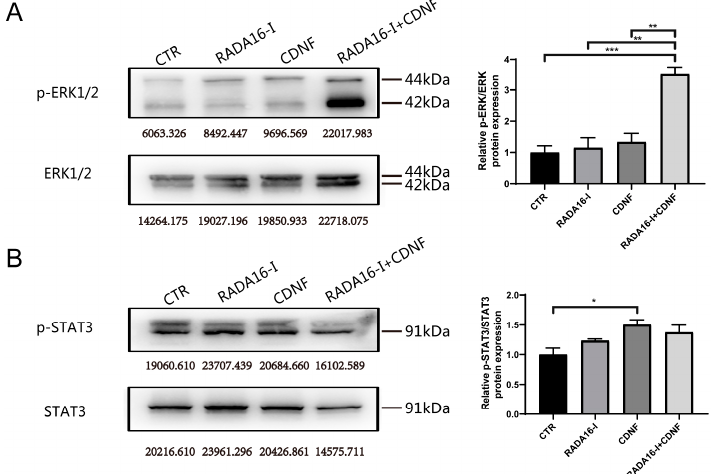
Figure 5. RADA16-I and CDNF promoted neural differentiation in MCAO rats. ( A ) BrdU (red)/GFAP (green)-positive cells were identified in the ischemic prenumbra four weeks after MCAO. DAPI (blue) was used to label the nuclei. The insets show photomicrographs of the ischemic penumbra at higher magnification. Arrows point to the BrdU/GFAP-positive cells. ( B ) Quantitative analysis of BrdU/GFAP-positive cells in the ischemic penumbra. ( C ) BrdU (red)/NeuN (green)-positive cells were identified in the ischemic prenumbra four weeks after MCAO. DAPI (blue) was used to label the nuclei. The insets show photomicrographs of the ischemic penumbra at higher magnification. Arrows point to the BrdU/NeuN-positive cells. ( D ) Quantitative analysis of BrdU/NeuN-positive cells in the ischemic penumbra. N = 5/group. ** p < 0.01, *** p < 0.001 according to ANOVA followed by LSD post hoc analysis. Scale bar = 45 µm.